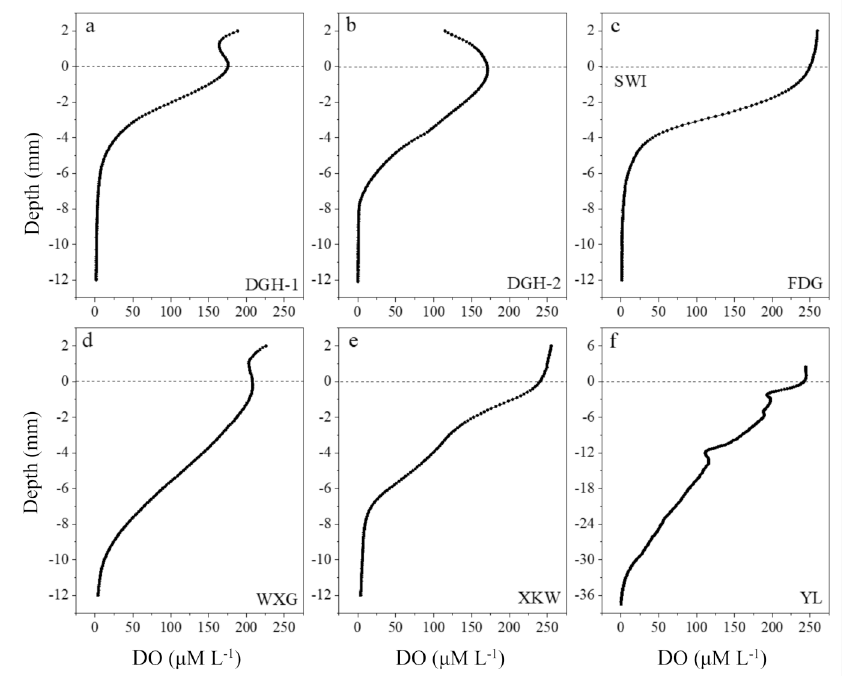
Figure 2. Dissolved oxygen concentration variation in sediment profiles of sampling sites, from June 2019. Dashed lines indicated approximate positions of sediment–water interface (SWI). Note the different Y-axis scaling in YL. ( a ) DGH-1 ( b ) DGH-2 ( c ) FDG ( d ) WXG ( e ) XKW ( f )